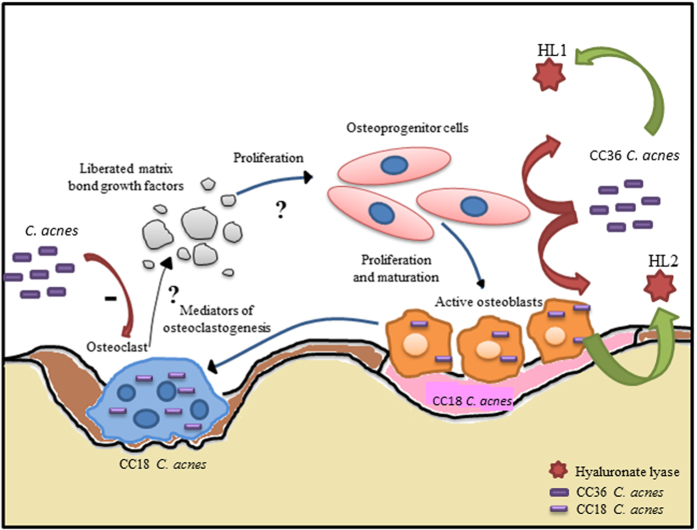
Schematic representation of the impact of Cutibacterium acnes on bone cells.Depending on the clonal complexes, there are two ways for C. acnes to interact with bone cells. On one hand, CC18 C. acnes can be internalized by osteoblasts and osteoclasts. On the other hand, CC36 C. acnes are less internalized. Moreover, infection of mature osteoclasts by C. acnes decreases their bone resorption ability with a major impact by CC36 isolates. A question mark highlights the remaining issues to understand better the interaction between C. acnes and bone cells.